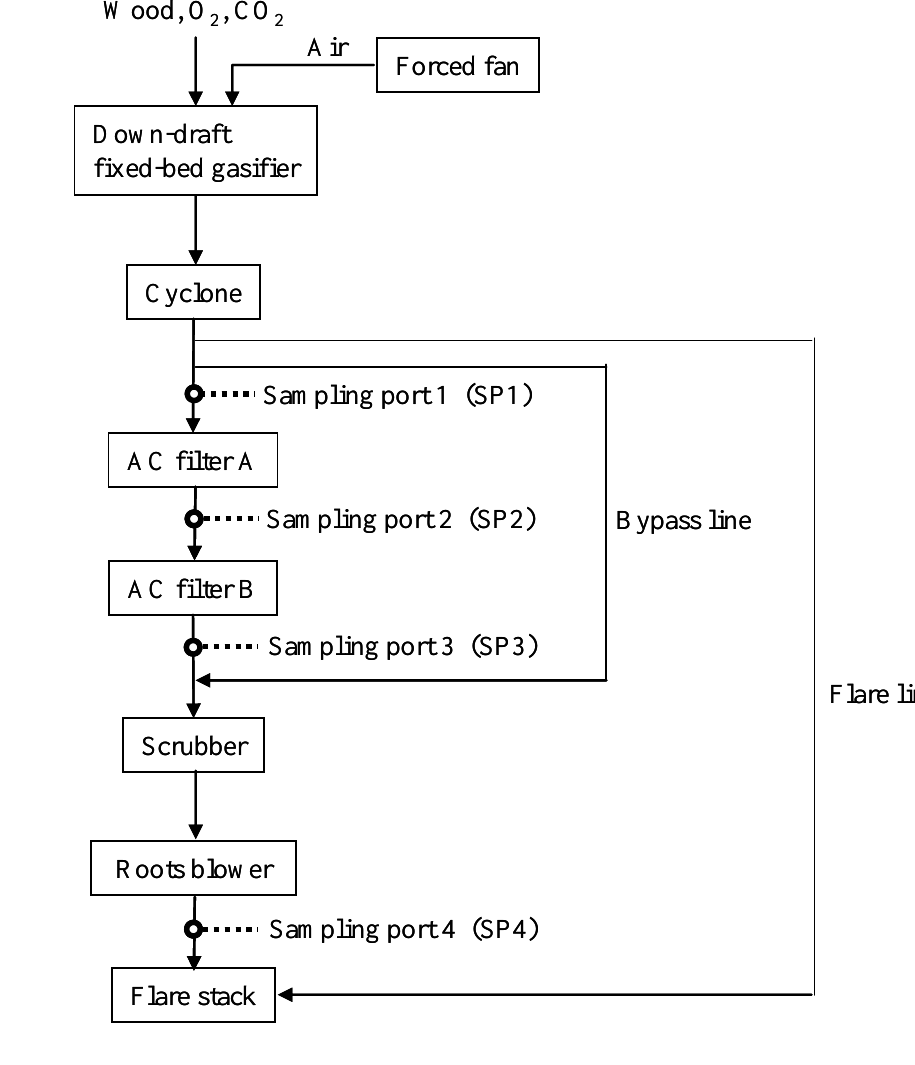
Figure 5. Schematic diagram for gas cleaning of product gas derived from biomass gasification.